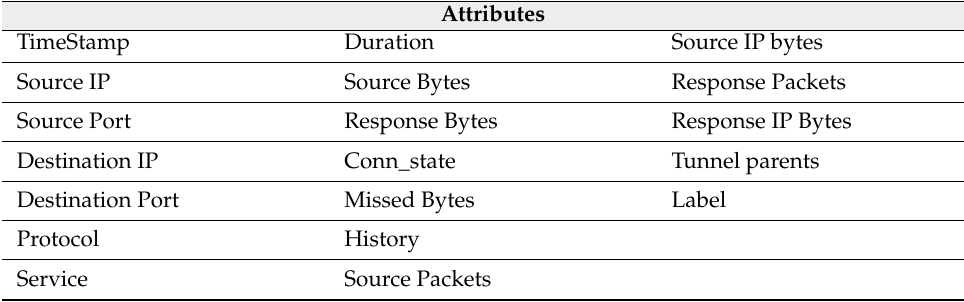
Table 7. Attributes collected using Zeek (end_conn.log